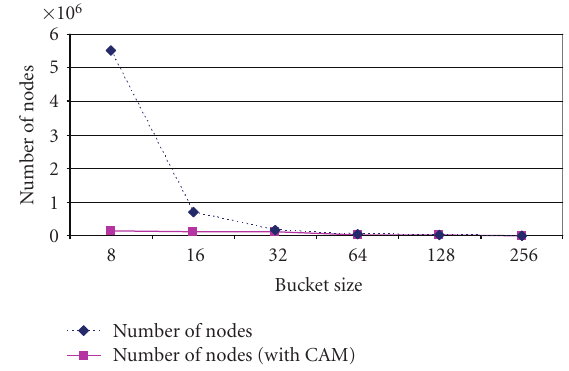
Figure 8: The e ff ect on the number of nodes of restricting the maximum depth of the tree (number of levels) to 5 using